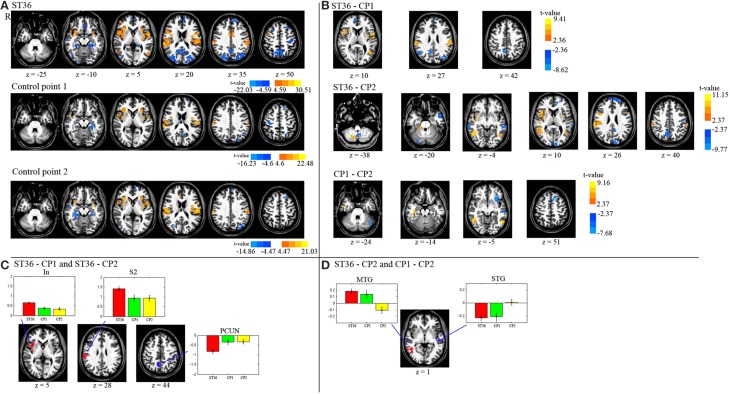
(A) Displayed are the activation and deactivation for the different point stimulations (group-level t-maps, P < 0.05, corrected). (B) The de/activation contrasts between the three different point locations are presented (P < 0.05, corrected). (C) The conjunction map of the 1st and 2nd row of part (B) (acupuncture vs. control points). (D) The conjunction map of the 2nd and 3rd row of part (B) (dermatome L5 vs. L2). The barplots show the beta values across participants (average and standard error) within the respective region. R means right hemisphere. Talairach z coordinates are displayed. positive values: red, negative: blue.